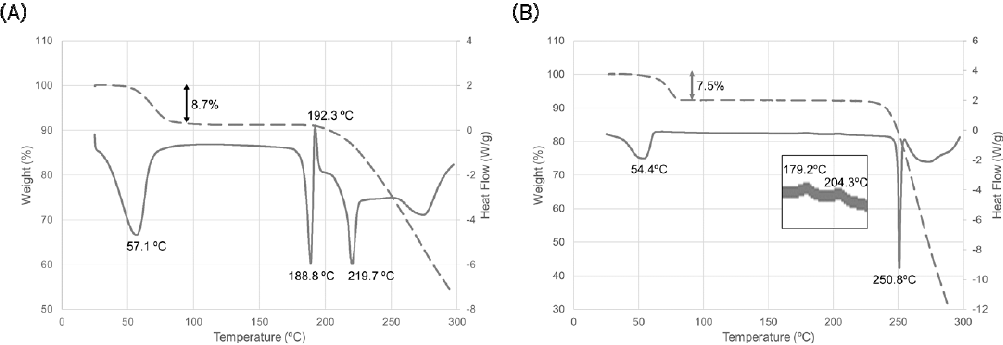
Figure 2. Thermal behavior of ondansetron salts. ( A ) HBr dihydrate and ( B ) HI dihydrate. Solid line indicates the differential scanning calorimetry (DSC) curve, dashed line indicates the thermogravimetric (TG) curve. Temperature on the DSC curve indicates the peak top temperature.